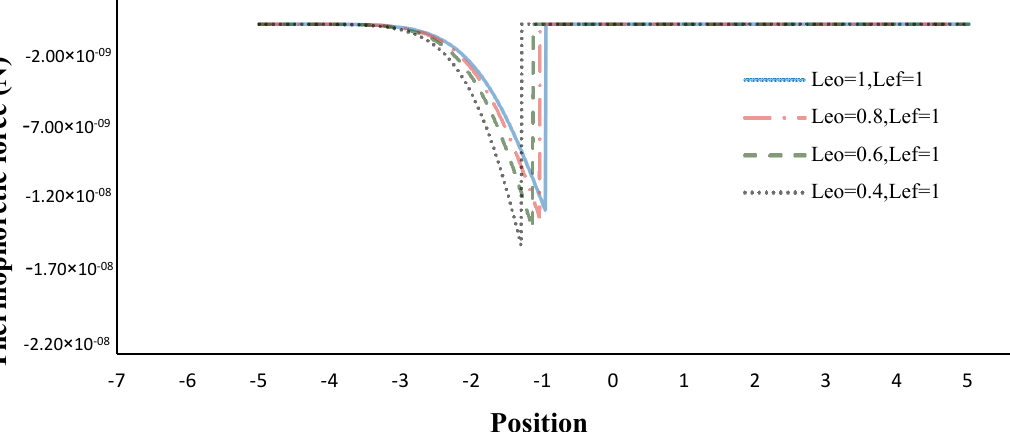
Figure 15. Thermophoretic force against the position for different oxidizer Lewis numbers.